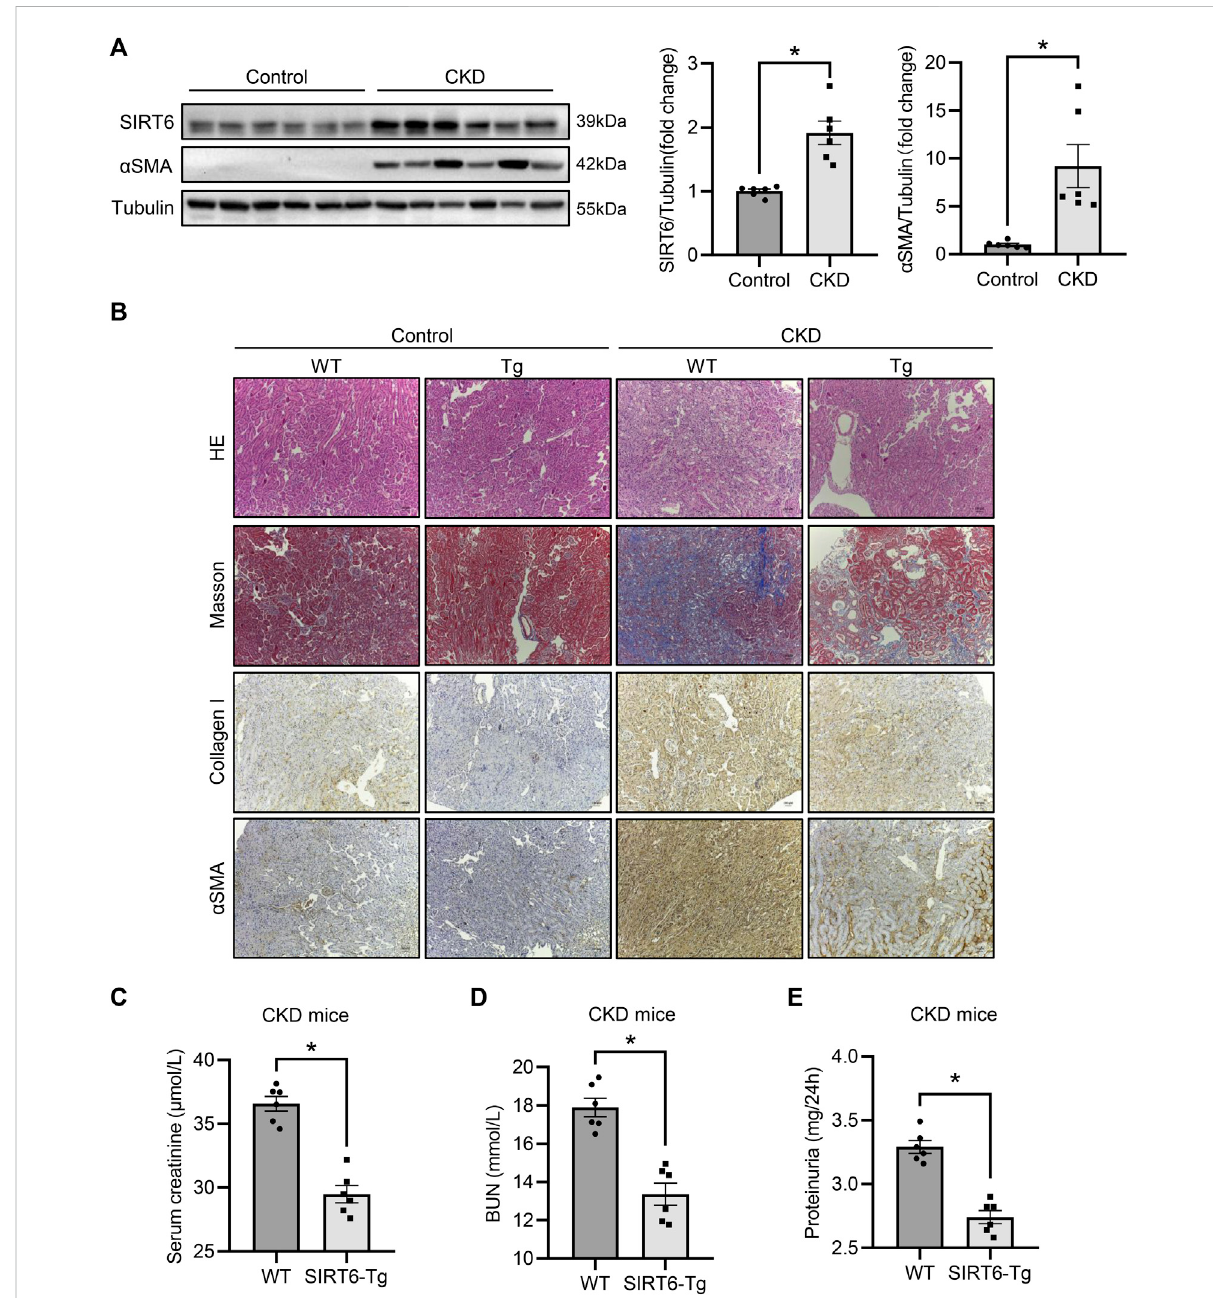
FIGURE 1 SIRT6 overexpression protected against renal interstitial fi brosis. (A) Western blot analysis of SIRT6 and α SMA expression in fi brotic kidneys of CKD mice. n = 6. (B) Representative hematoxylin and eosin staining, Masson trichrome staining and immunohistochemical images of collagen I and α SMA expression in kidneys. Scale bar, 100 μ m. (C – E) Sera from WT and SIRT6-Tg of CKD mice were tested for serum creatinine, BUN and proteinuria for 24 h n = 6. All values are presented as mean ± SEM. * p <